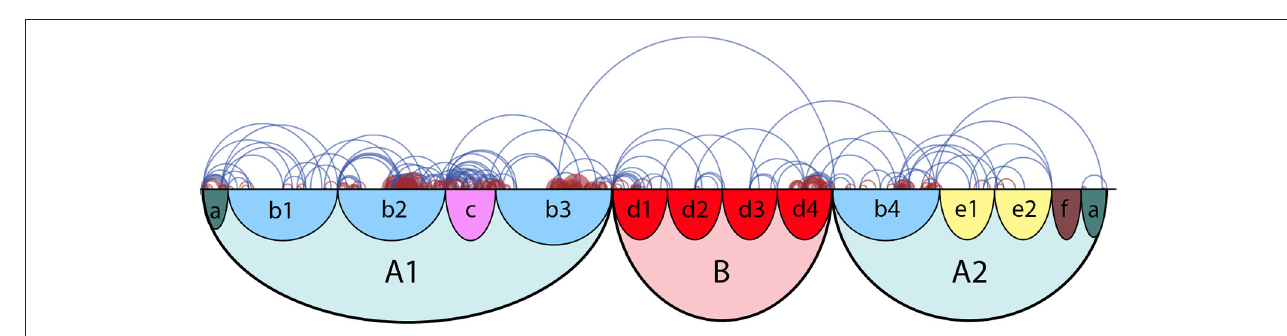
FIGURE 6 | Illustration of Practice Segment Arcs: Practice Segment Arcs for expert player E1 (upper half) with formal structure of piece (lower half).